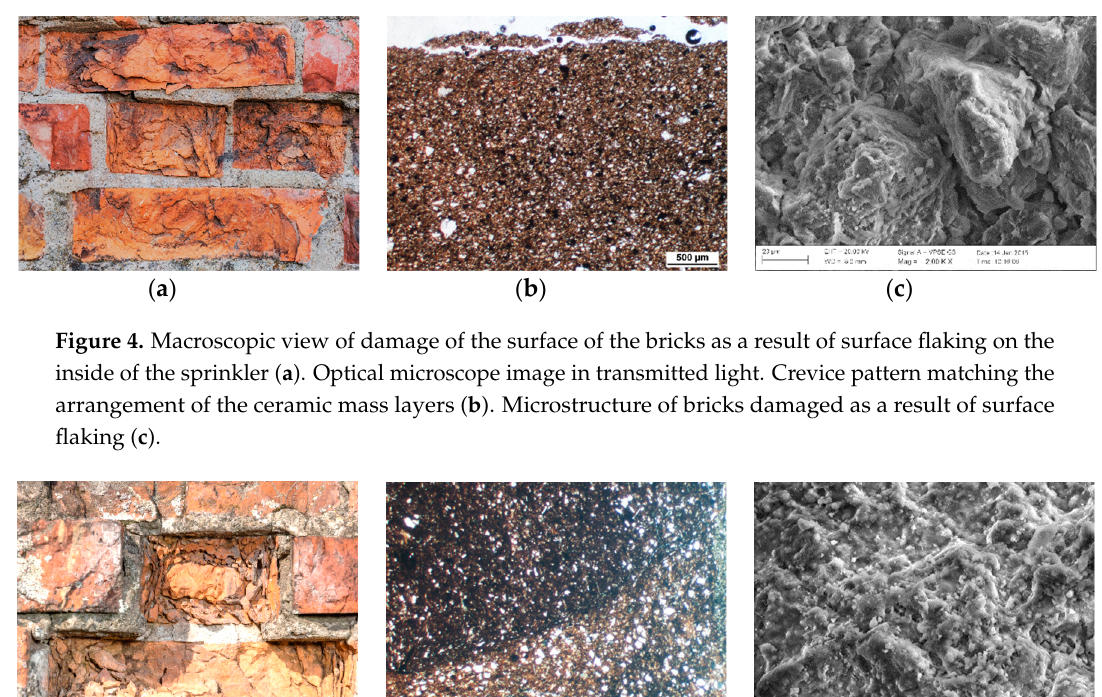
Figure 3. Macroscopic view of damage of the surface of the bricks as a result of surface powdering ( a ). Transmitted light optical microscopy image. Homogeneous structure of the ceramic mass ( b ). Microstructure of bricks damaged as a result of surface powdering ( c ).